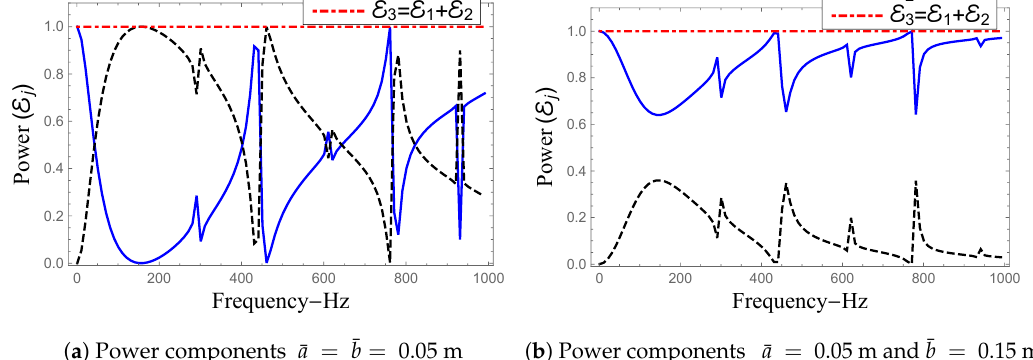
( b ) Power components ¯ a = 0.05 m and ¯ b = 0.15 m Figure 7. Scattering powers against frequency.